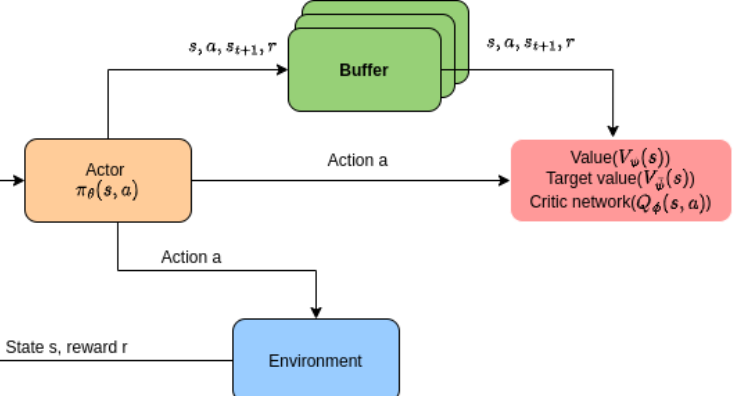
Figure 1. This figure shows the overall architecture of SAC algorithm. SAC has three main compo- nents: the soft state-value function, soft Q-function, and